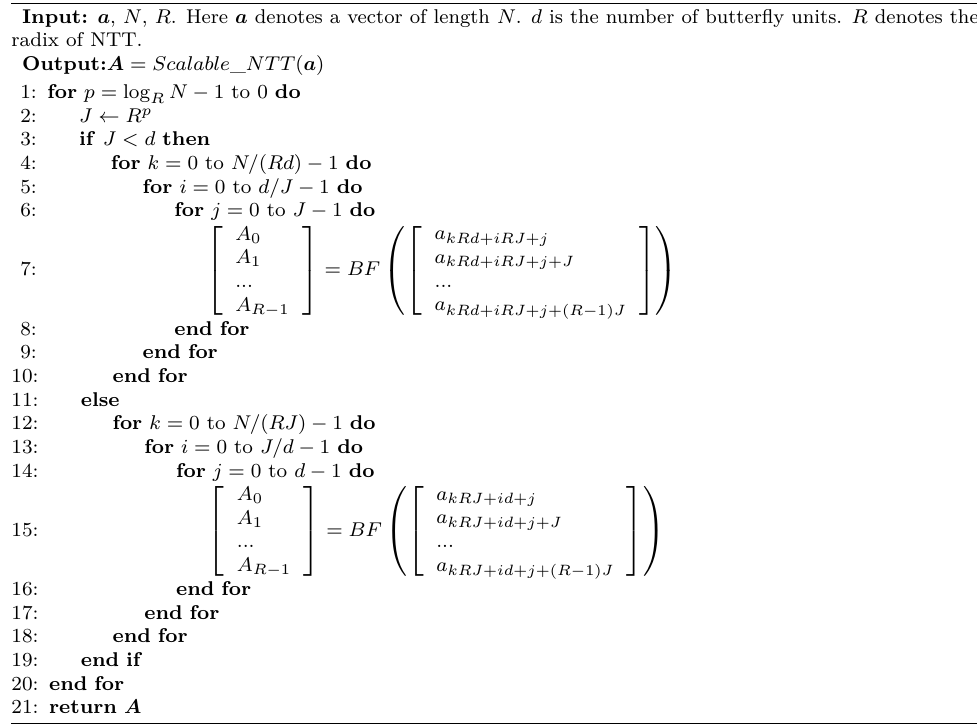
Algorithm 6 Scalable Iterative NTT